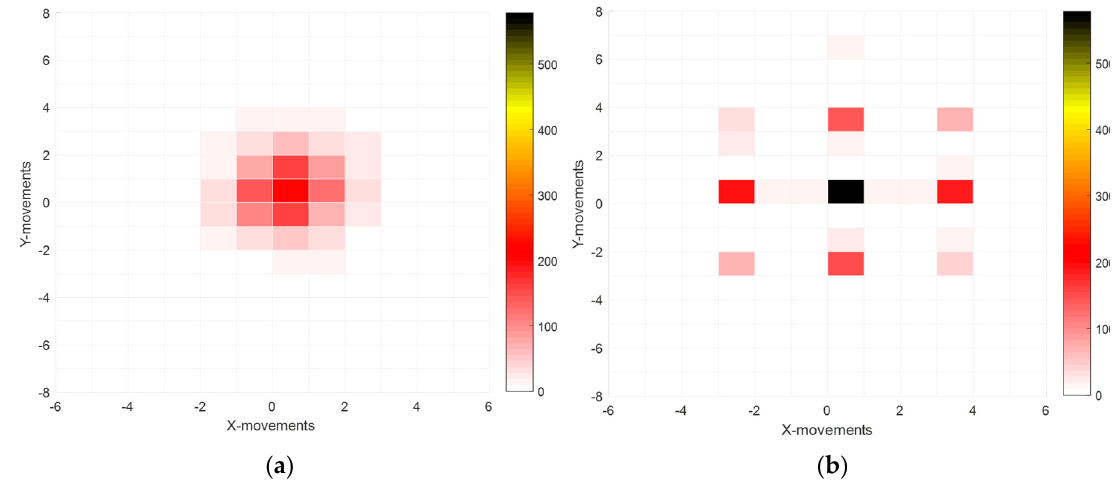
Figure 8. 2D histogram of temporal fluctuations in the Pattern Test (X and Y movements are in pixels). ( a ) Measured at distance z 3 . ( b ) Estimated at z 3 from distance z 1 and z 2 . Source: